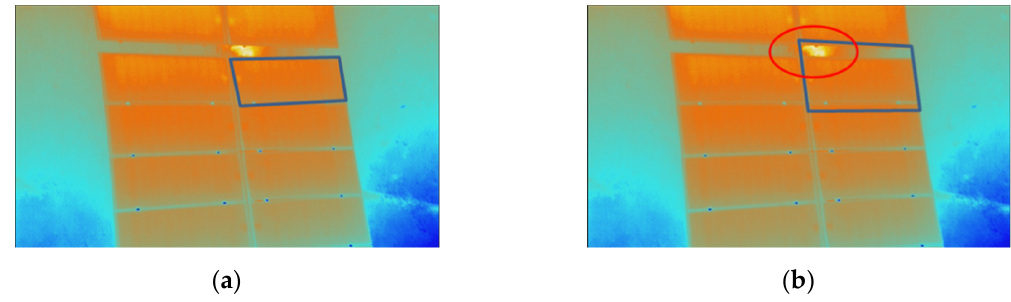
Figure 1. Examples of photovoltaic module area extraction and decision: ( a ) Correct extraction; ( b ) Incorrect extraction.